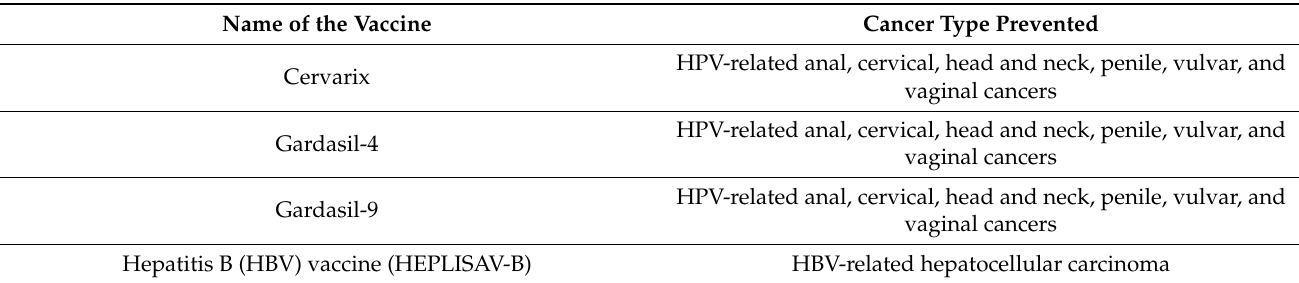
Table 1. List of FDA-approved preventive cancer vaccines.